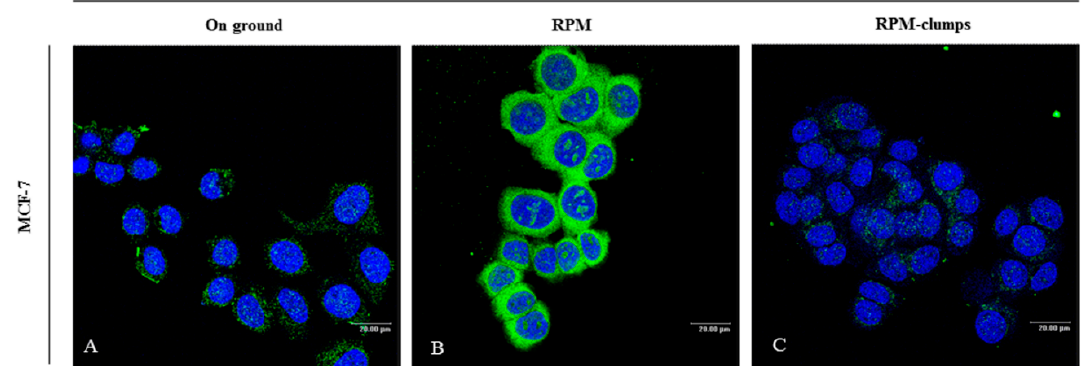
Figure 8. Confocal images of β 1-integrin (in green) distribution in MCF-7 cultured in normal gravity ( A ) and microgravity conditions ( B , C ) for 24 h. β 1-integrin in MCF-7 cells appears localized on the cell membrane both in the on-ground condition and in RPM-cultured cells. β 1-integrin shows an increased deposition in RPM-AD ( B ) when compared to control cells cultured on ground. In the RPM-CLUMP cluster, β 1-integrin is almost completely absent ( C ). Nuclei (in blue) were stained with TO-PRO-3 iodide. Scale bars 20 µm.